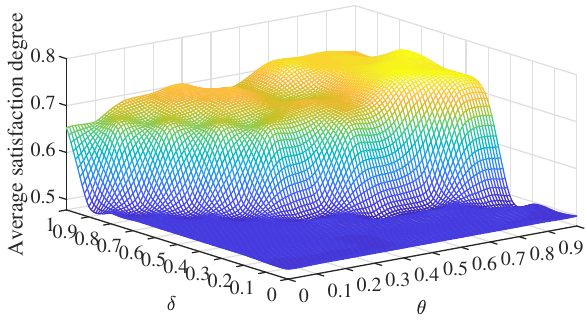
Figure 1. Average DMU satisfaction degree for different values of θ and δ .